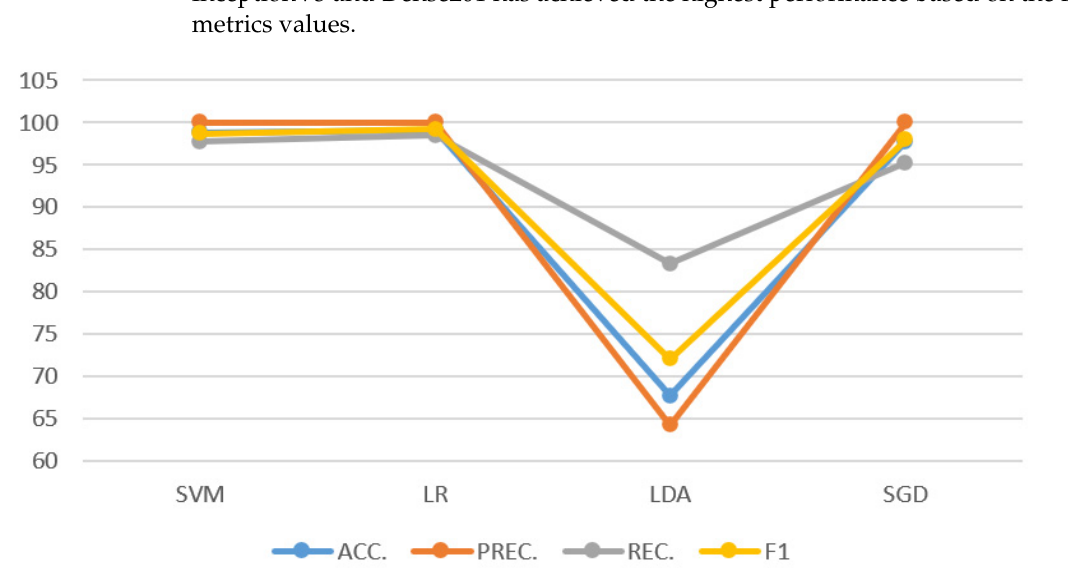
Figure 11. Performance of classifiers on features extracted from both InceptionV3 and Dense- Net201.